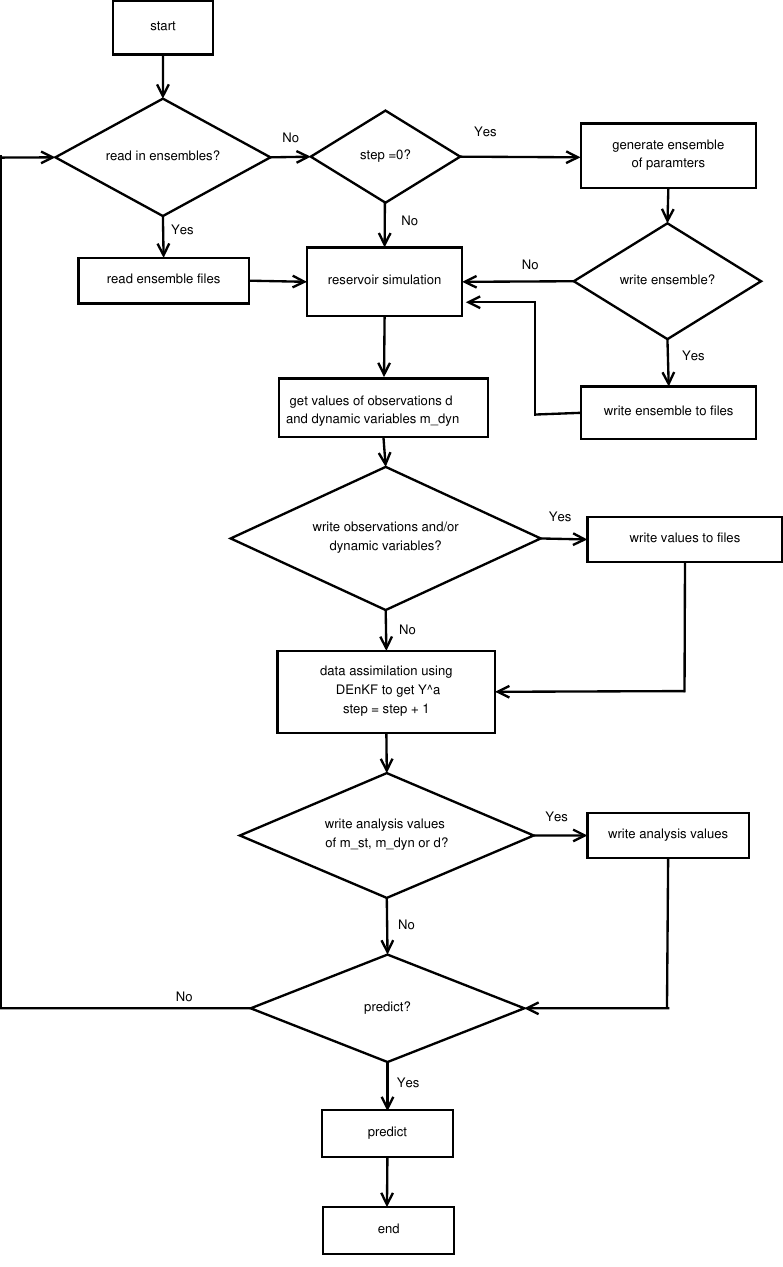
Figure 1. The flowchart of the